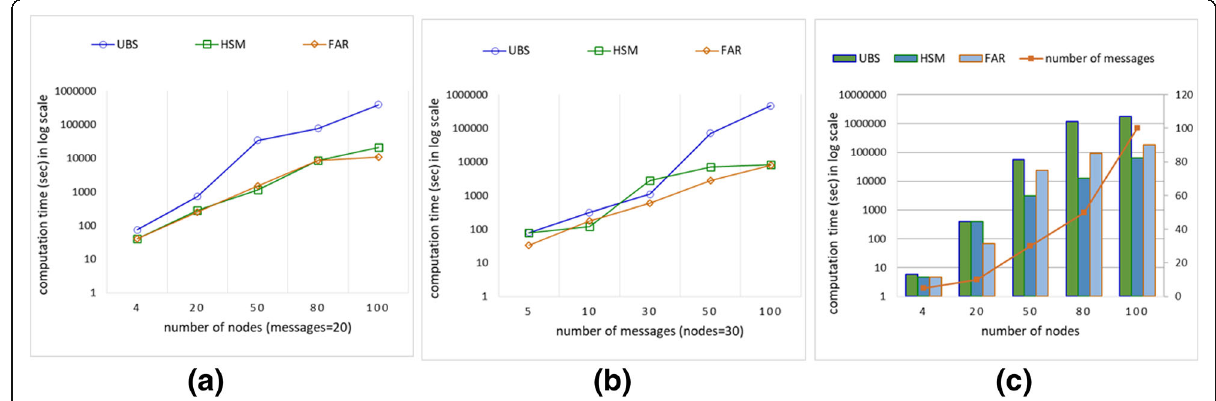
Fig. 14 Computation time of the proposed schemes by varying the number of a nodes, b messages, and c nodes and